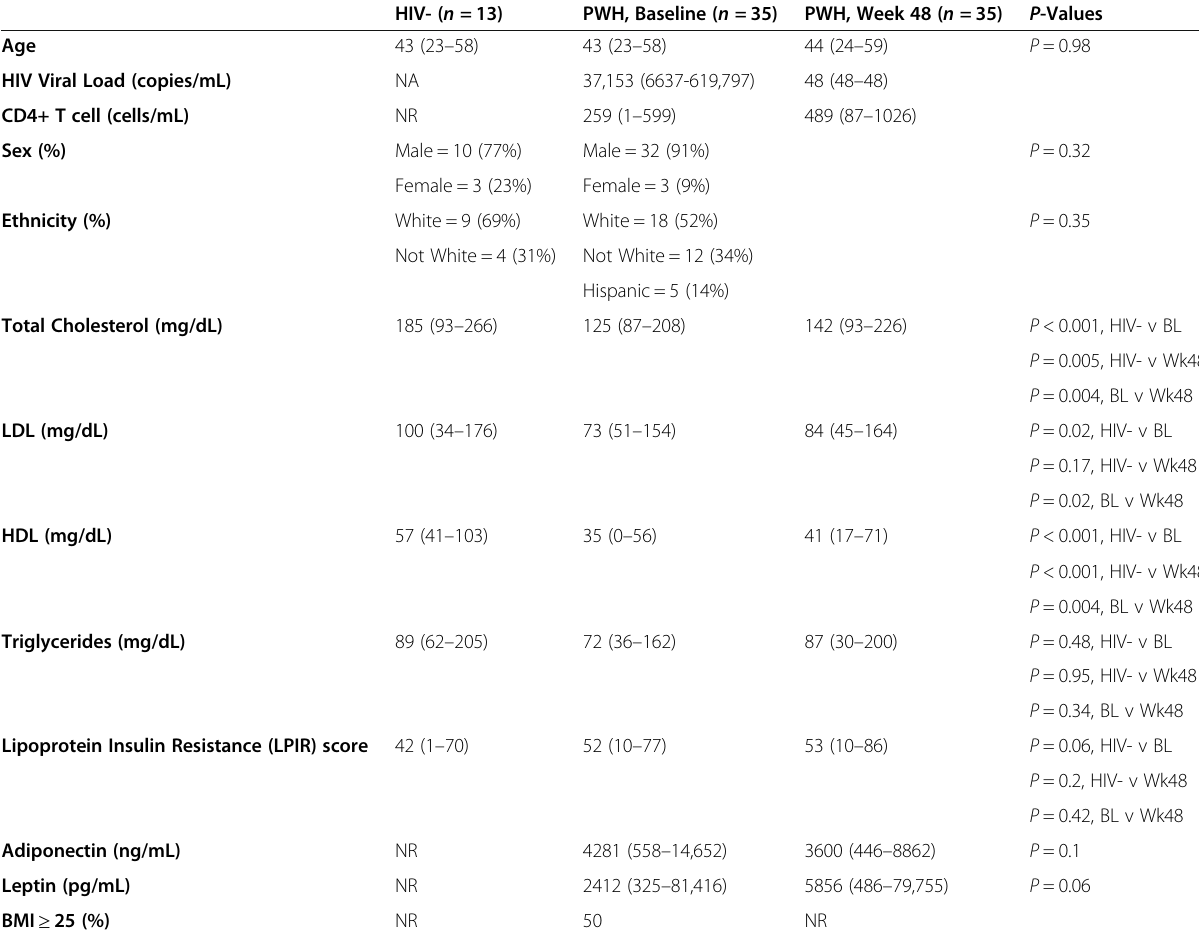
Table 1 Study participant